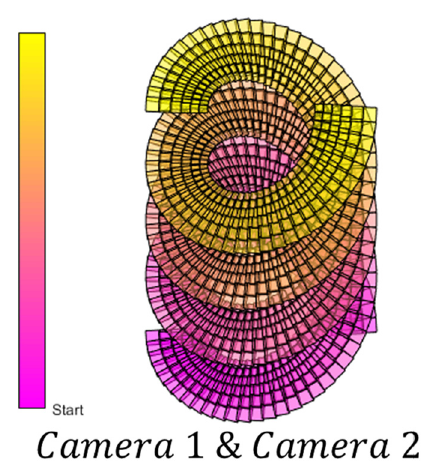
Figure 14. Dual-camera OCPSI mode overlay schematic: merging.